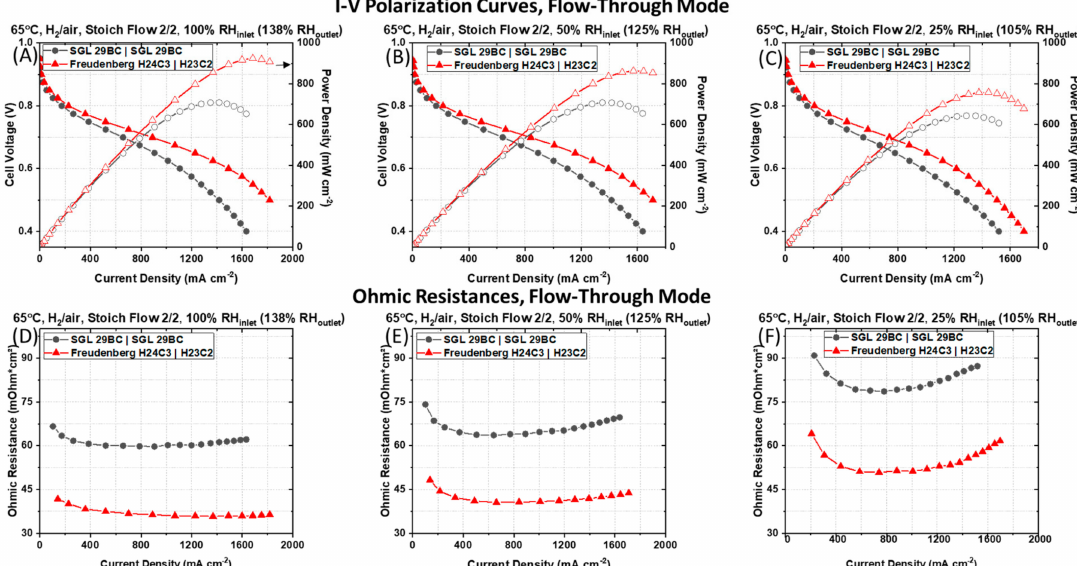
Figure 2. I–V polarization and power densities curves ( A – C ) with the associated Ohmic resistances ( D – F ) measured for a PEMFC containing a typical symmetric pairing of SGL 29BC GDM on the anode and cathode side and a PEMFC containing an asymmetrical pairing of Freudenberg GDM [i.e., H24C3 (anode) | H23C2 (cathode)] recorded at a cell temperature of 65 ◦ C, ambient pressure, in H 2 | air environment at stoichiometric flow rates of 2 | 2 at ( A , D ) 100%, ( B , E ) 50% , and ( C , F ) 25% RH inlet , respectively, from left to right